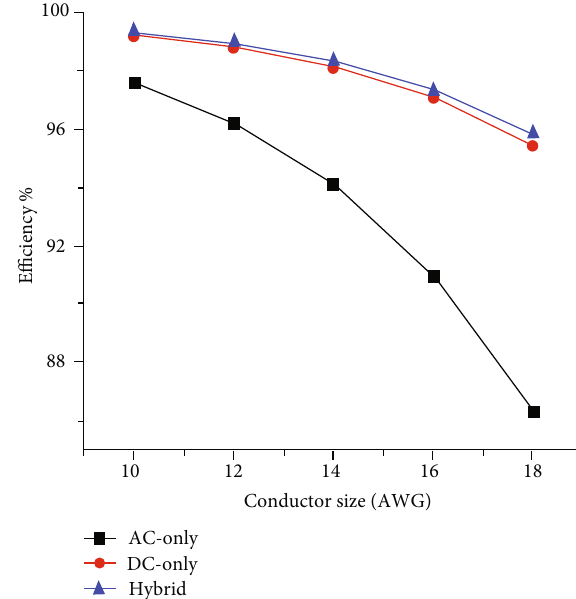
Figure 26: Distribution line losses and e ffi ciency.